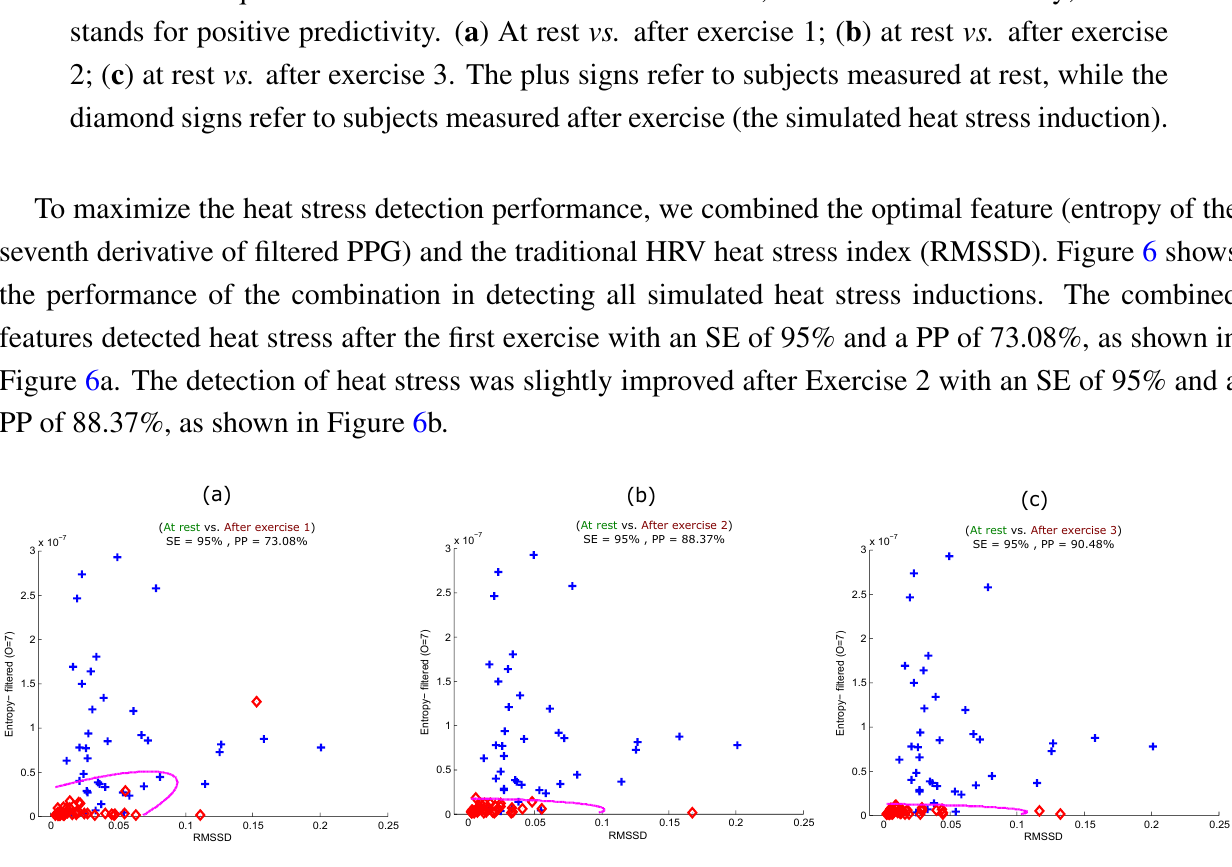
(c) (At rest vs. After exercise 3) SE = 92.5% , PP =